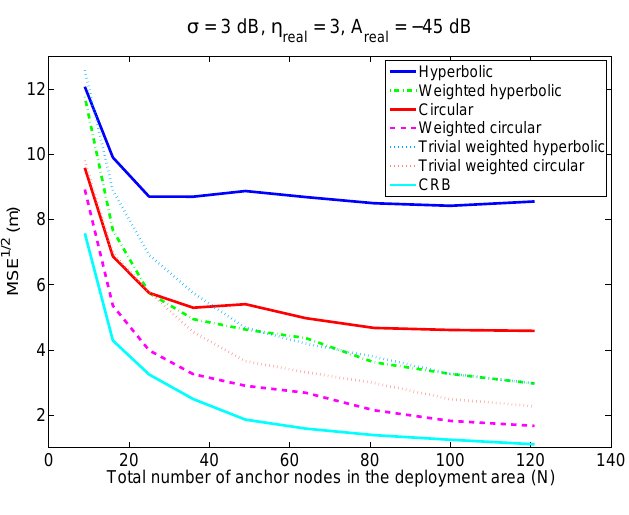
Figure 3. Average localization error (calculated as the square root of the MSE) of the four positioning methods as a function of N , for an environment with A σ = 3 dB. The Cramer–Rao bound is shown as comparison. The values of n corresponding to these values of N vary between 6.2 and 50.